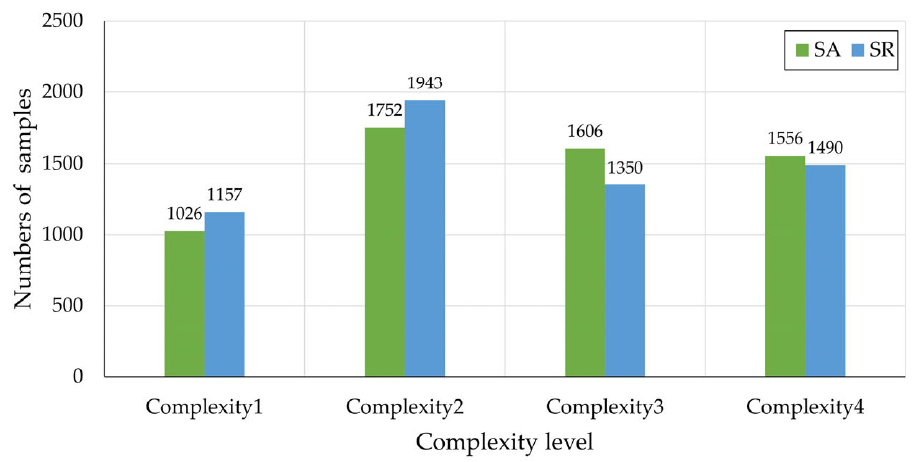
Figure 9. Basic information of 2 experimental sectors.